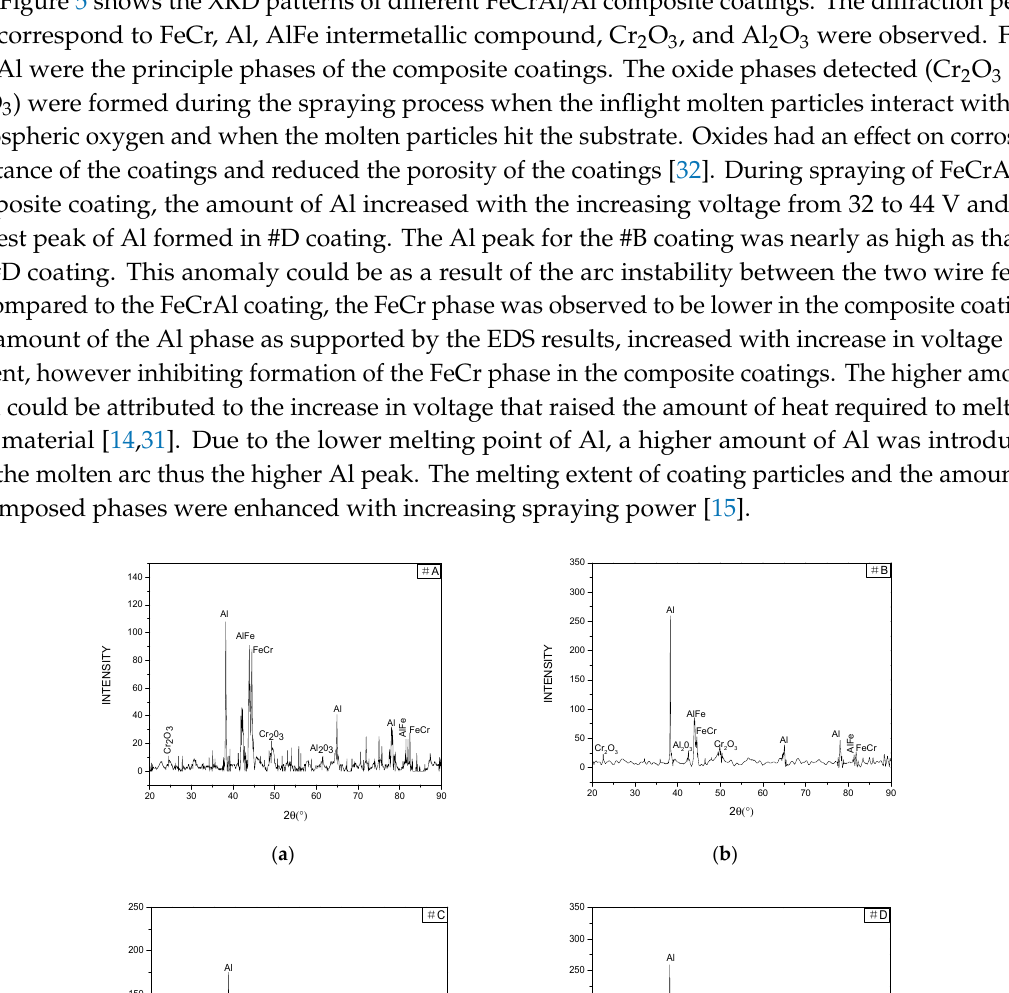
Figure 4. Energy-dispersive X-ray spectroscopy (EDS) analysis of the ( a ) FeCrAl coating and ( b ) FeCrAl / Al coating.